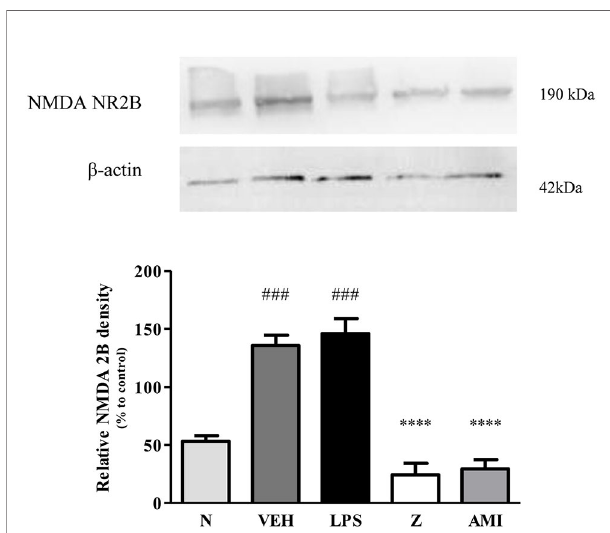
FIGURE 14 | Representative western blots of NMDA NR2B receptor from LPS-induced SH-SY5Y cells samples of normal, vehicle, LPS only, zerumbone, amitriptyline-treated groups. Data presented as mean ± SEM (n = 4), which were normalized to b -actin. **** p < 0.0001 as compared to LPS only group and ### p < 0.001 as compared to normal group. N (Normal); VEH (Vehicle, PBS); Z (Zerumbone, 8 m g/ml); AMI (Amitriptyline, 16 m